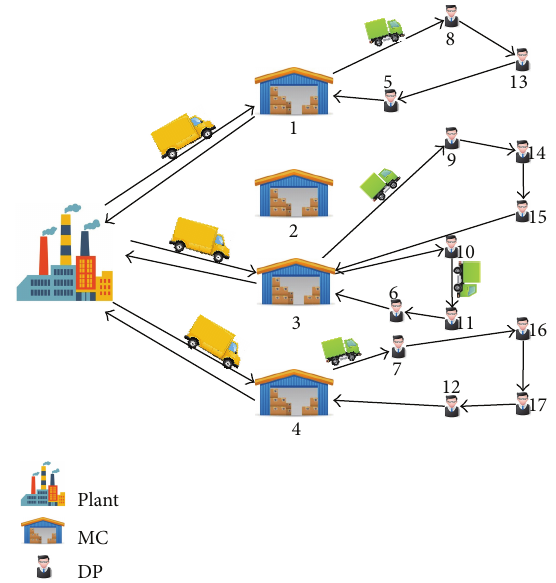
Figure 1: Closed-loop supply chain for a single